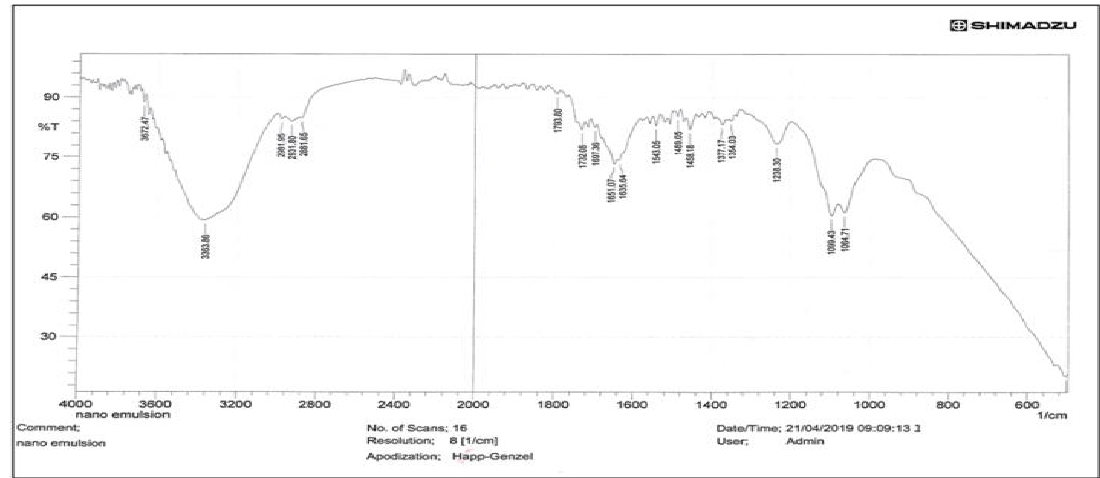
Figure7. FTIR spectrum of optimized formula (NE9 ) Field emission scan electron microscope(FESEM)